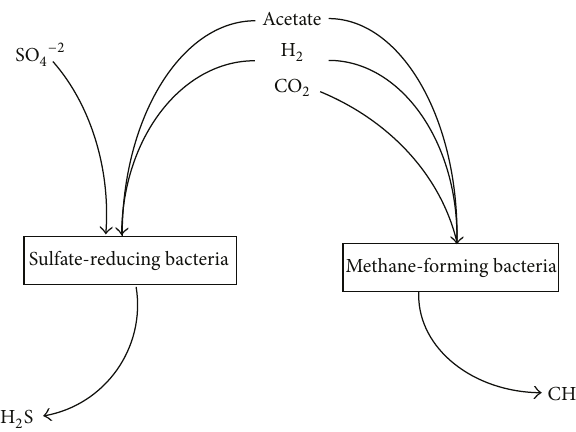
Figure 1: Many different groups of bacteria within the anaerobic digester often compete for the same substrate and electron acceptor. Methane is produced by methane-forming bacteria and a variety of acids and alcohols are produced by sulfate reducing bacteria. Hydrogen is used with sulfate (SO 4−2 ) by sulfate-reducing bacteria and hydrogen sulfide (H 2 S) is produced.